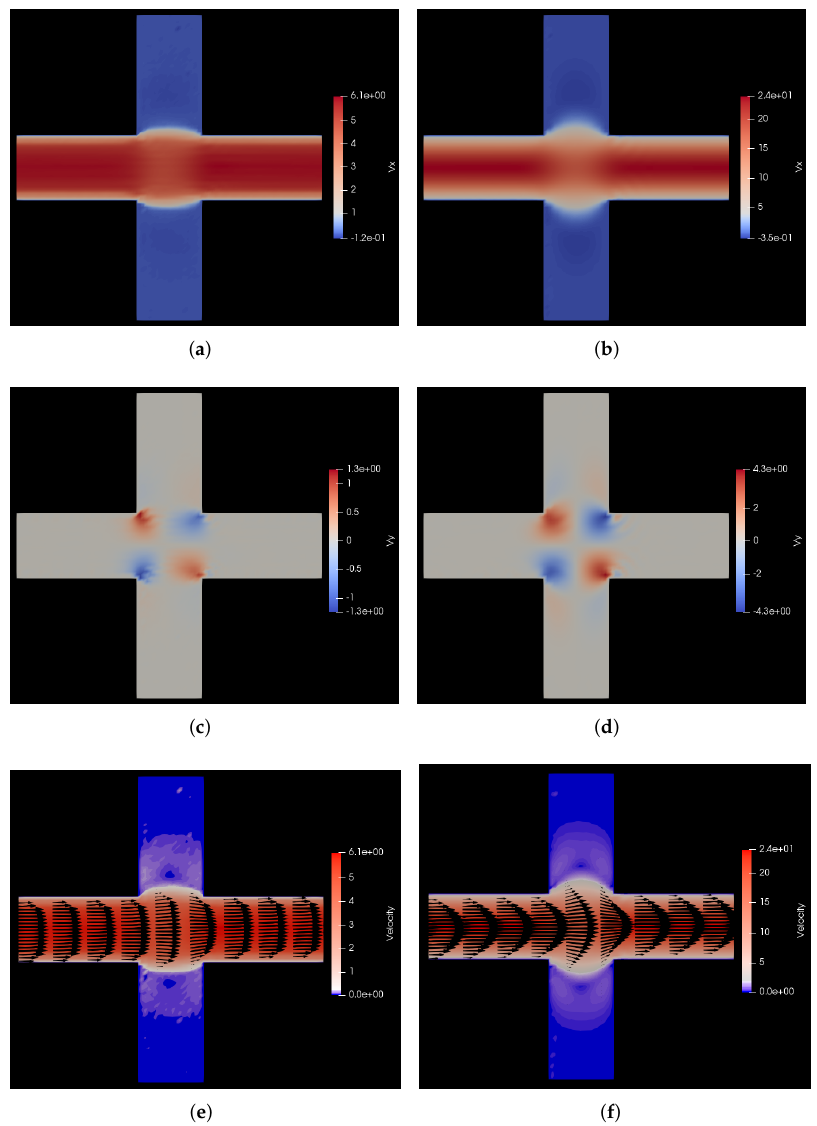
Figure 7. Comparison of velocity profiles for flow of polymer solution with the flow of solvent through a cuboidal porous medium with pressure applied in the positive x direction. ( a ) v x for flow of polymer solution. Here, v x varies from − 0.12 to 6.1 σ /s, i.e., − 0.6 to 30.5 µ m/s; ( b ) v x for flow of solvent. Here, v x varies from − 0.35 to 24 σ /s, i.e., − 1.75 to 120 µ m/s; ( c ) v y for flow of